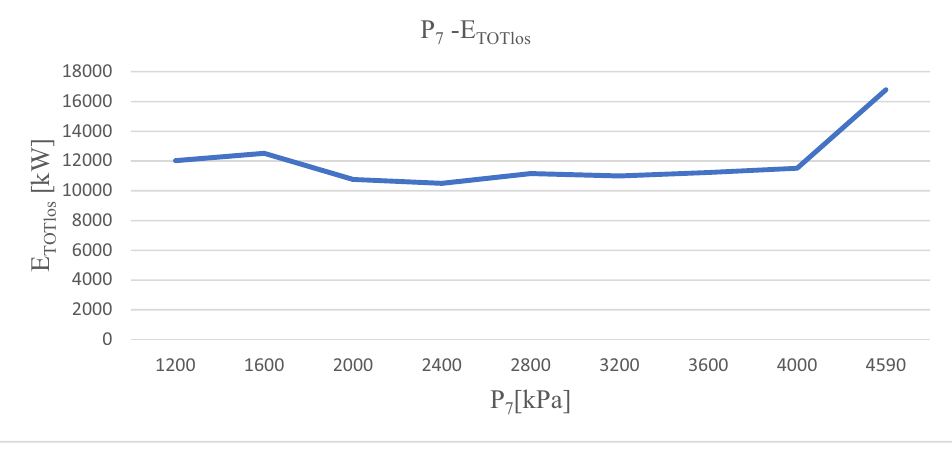
Figure 6: Exergy loss curves of the entire cycle obtained for di ff erent outlet pressures at which the fi rst - stage compressor of the vapor compression two - stage cascade cryogenic cycle can